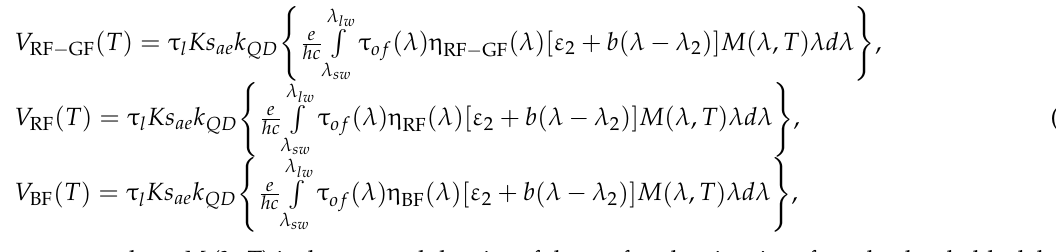
Figure 7. Resulting spectral quantum efficiencies in three spectral regions, formed using an external bandpass filter and a combination of recorded signals. bandpass filter and a combination of recorded